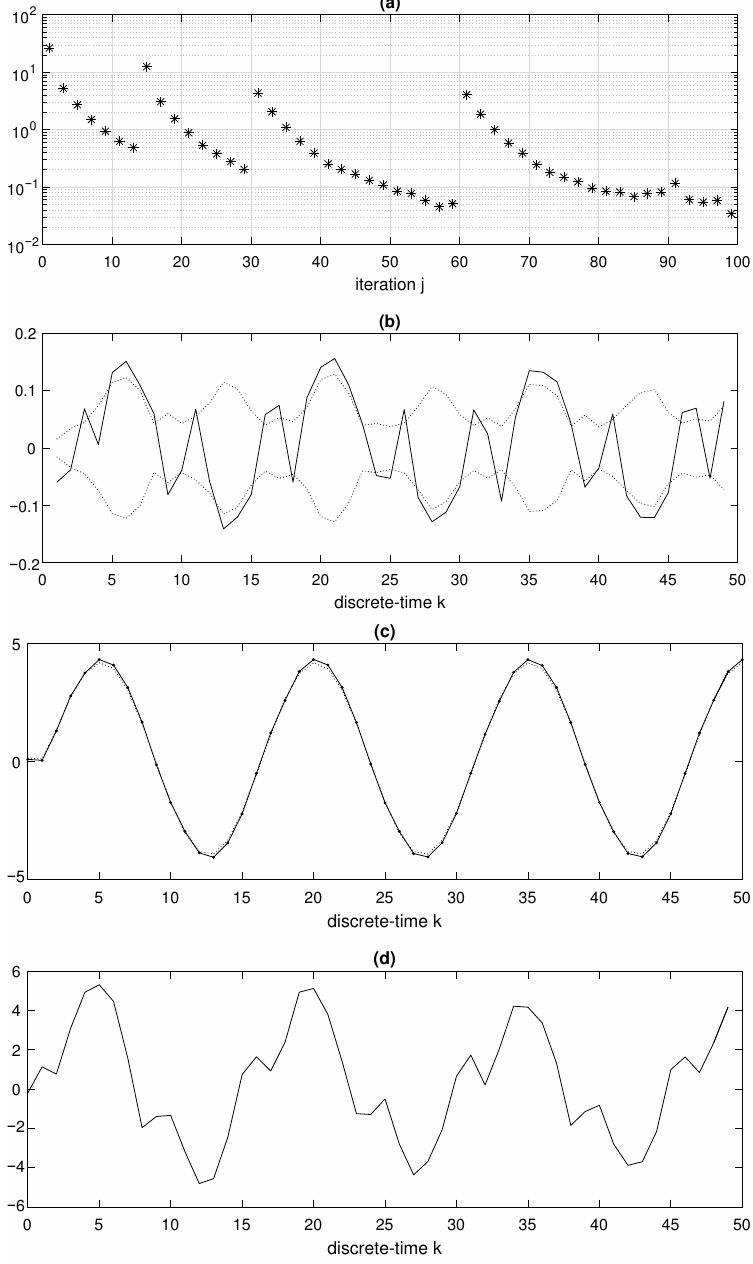
( k ) | ( ∗ ) versus iteration j . ( b ) e 100 ( k ) (solid line) and φ 100 ( k ) , − φ 100 ( k ) Figure 3. ( a ) max k ∈{ 1, ··· ,50 } | e j φ (dotted lines) versus discrete-time k . ( c ) y 100 ( k ) (solid line) and y 100 time k . ( d ) u 100 ( k ) versus discrete-time k